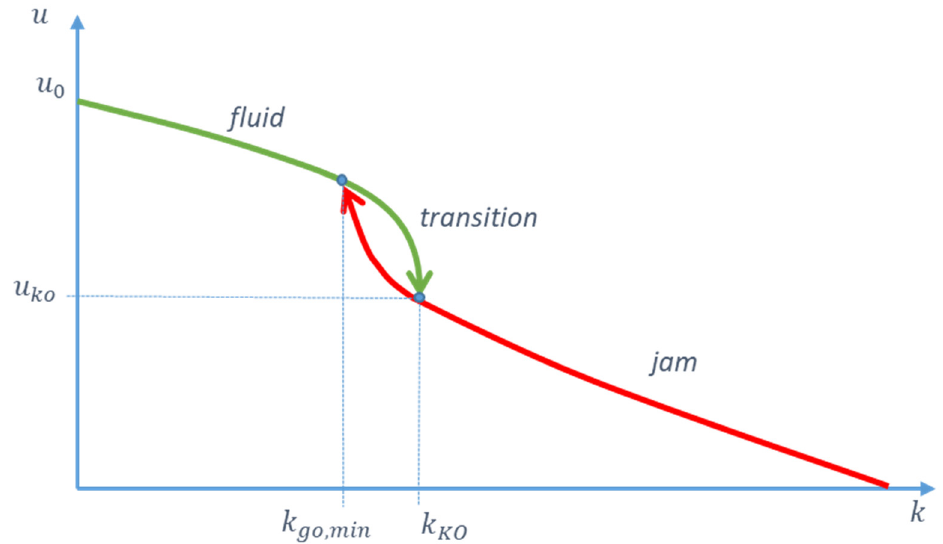
Figure 11. The hysteresis within transition phase between fluid and jam traffic.